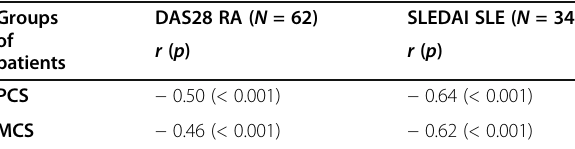
Table 2 Correlation between disease activity in both female cohorts and physical and mental component summary scores of